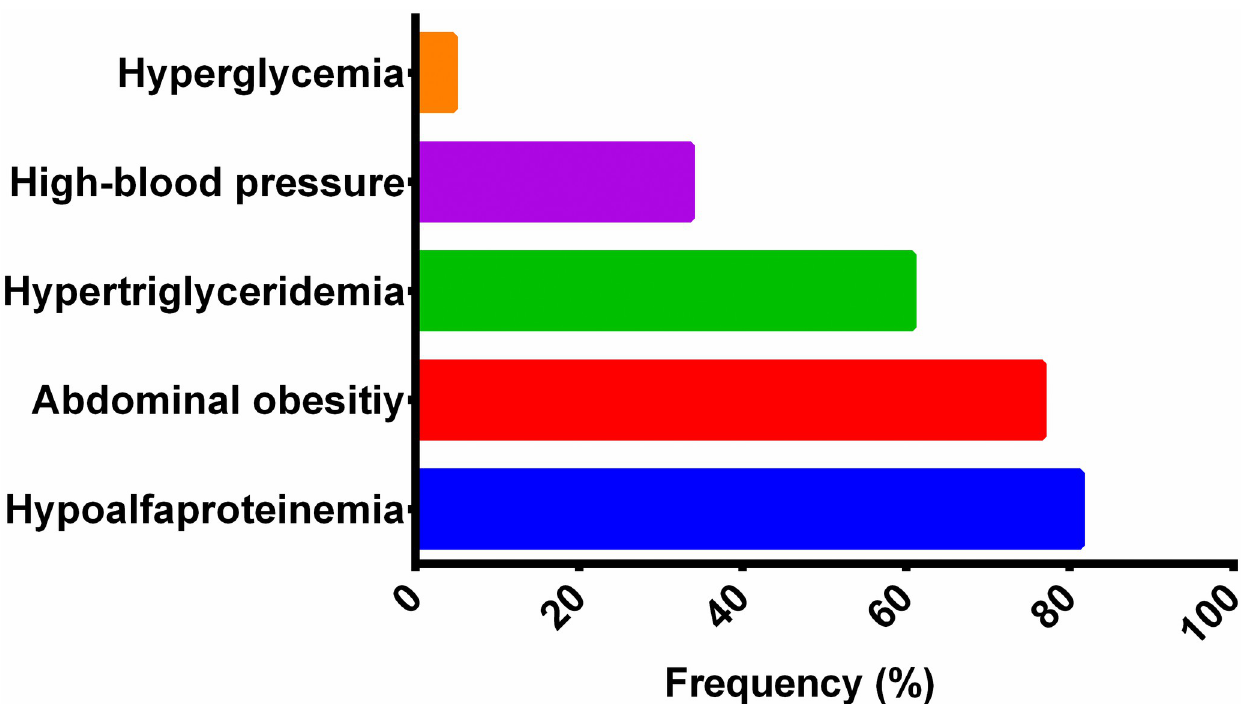
Fig 1. Frequency of the Ferranti criteria used for the diagnosis of metabolic syndrome. HDL-C levels, and 4.67% presented with hyperglycemia (Fig 1). Anthropometric, biochemical, adipokine, and cytokine characteristics Sample anthropometric, biochemical, adipokine, and cytokine characteristics are described in Table 1. Compared with children with normal body weight, those with overweight/obesity and MetS had significantly higher BMI, systolic blood pressure (SBP), diastolic blood pressure (DBP), TGL, and MCP-1, and significantly lower HDL-C and TGL/HDL-C ratio (4.51(3.15); p < 0.0001). There were no significant differences on indices between the children with over- weight/obesity without MetS and those with normal body weight (p > 0.05) (Table 1). After bivariate analysis, we found that children with high levels of HDL-C have lower prob- ability of having MetS (OR = 0.88, 95% CI = 0.81–0.95, p = 0.002). In addition, children with high levels of TGL have lower probability of having MetS (OR = 1.022, 95% CI = 1.01–1.033, p < 0.001). Serum leptin, resistin, PAI-1, and CRP levels differed significantly between children with normal body weight and those with overweight/obesity, and between those with and without MetS (all p < 0.05), being higher in children with overweight/obesity and MetS. The highest adiponectin levels were in children with normal body weight (31.13; IQR 12.46–36.90 mg/mL) and the lowest were in children with overweight/obesity with MetS (23.82; IQR 15.56–32.87 mg/mL). In contrast, the highest leptin levels were in children with overweight/obesity without MetS (18.17; IQR 11.74–29.17 ng/mL) and the lowest were in those with normal body weight (2.31; IQR 1.47–4.90 ng/mL) (Table 1). Consequently, the Adipo/Lep ratio was highest in children with normal body weight (6.68(7.89)), lower in those